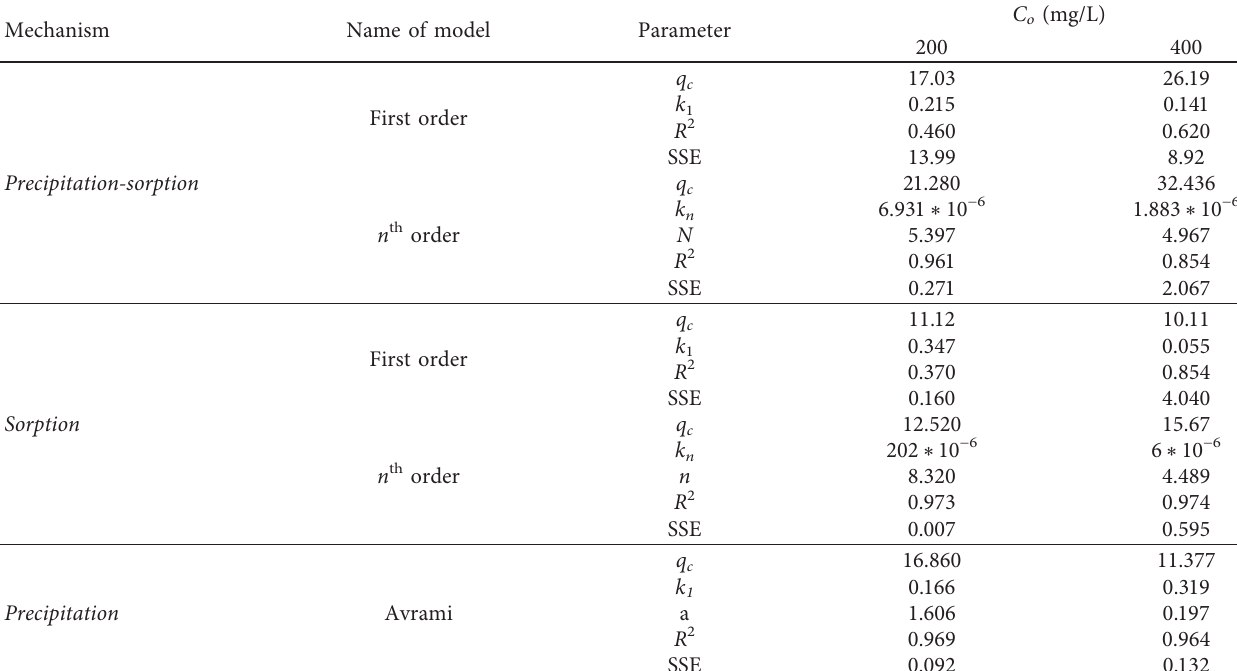
Table 3: Simulation of predominant mechanisms by different kinetic